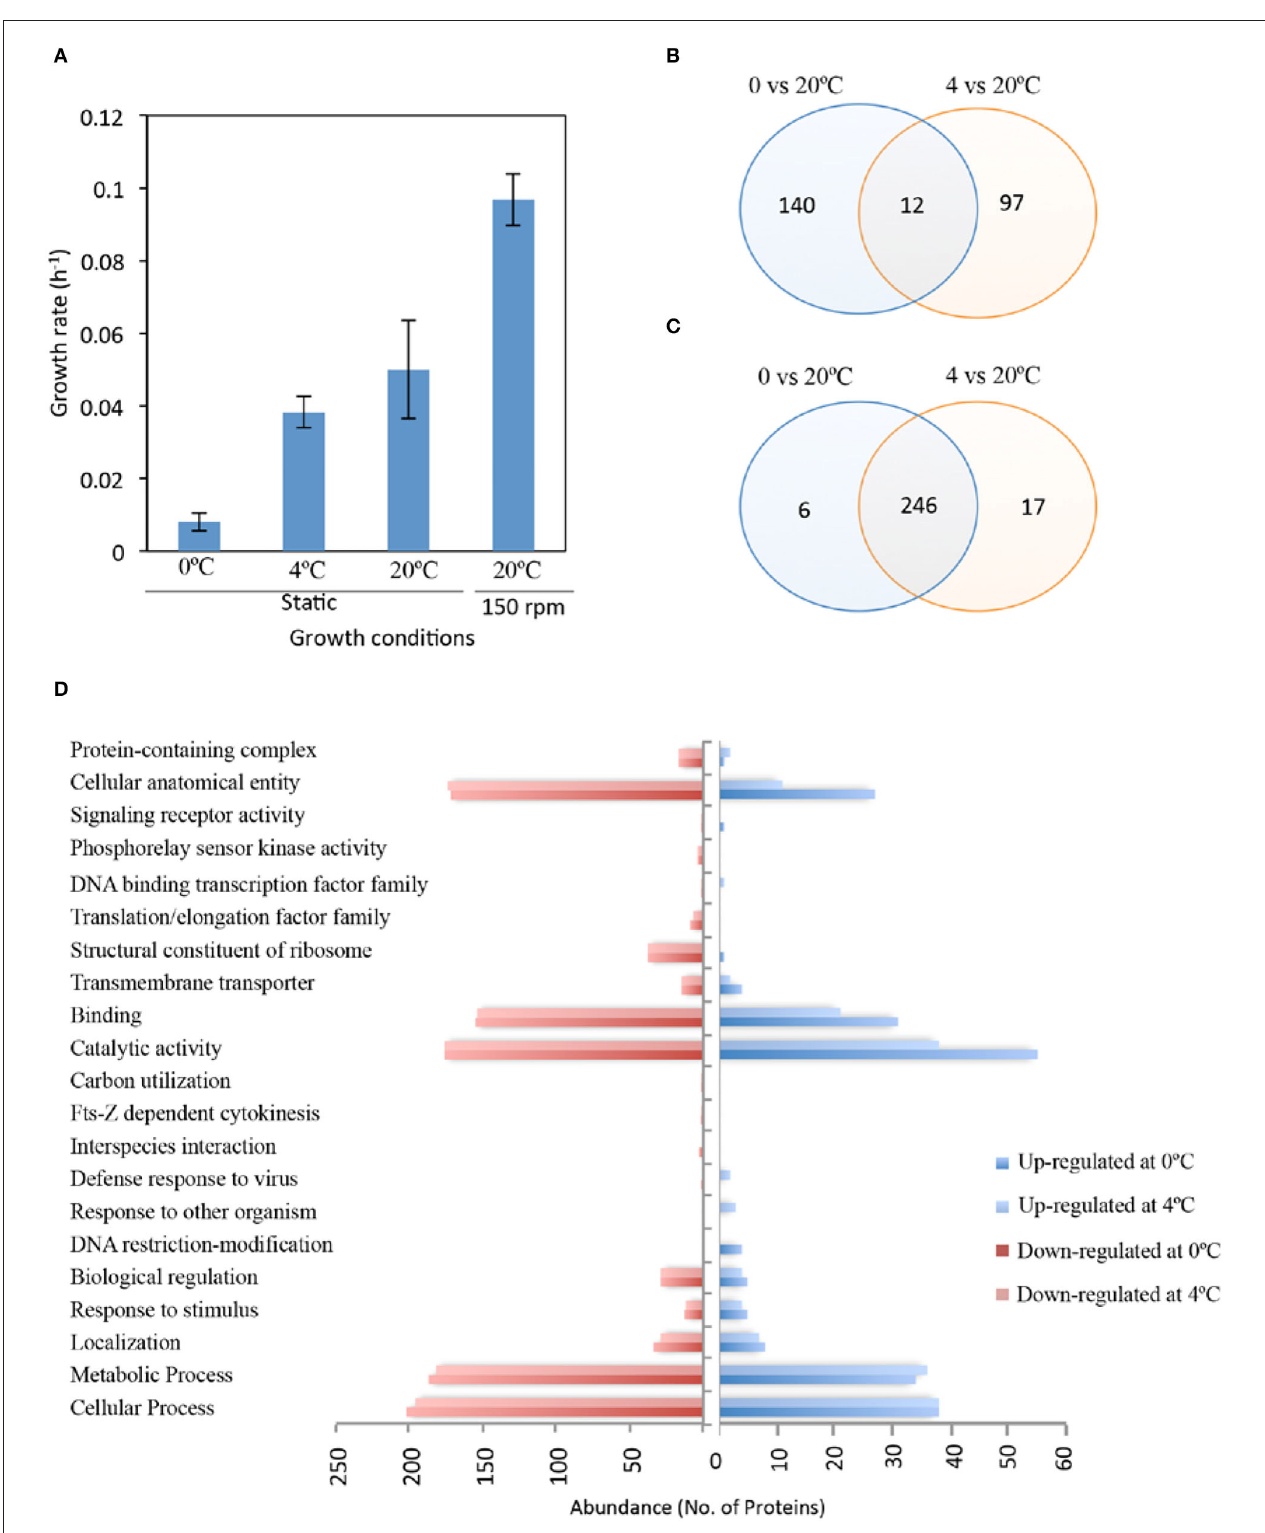
FIGURE 2 | Growth and proteomic response of Iodobacter sp. PCH194 in cold/freeze conditions. (A) Growth rate (OD 460 ) of Iodobacter sp. PCH194 at different temperatures in nutrient broth medium, (B) Venn diagram showing the total and shared number of upregulated, and (C) downregulated protein targets in response to cold (4 ◦ C) and freeze (0 ◦ C) compared to 20 ◦ C identified by gel-based and gel-free proteomics approaches, and (D) the abundance of upregulated and downregulated proteins with functional categorization by UniProt.